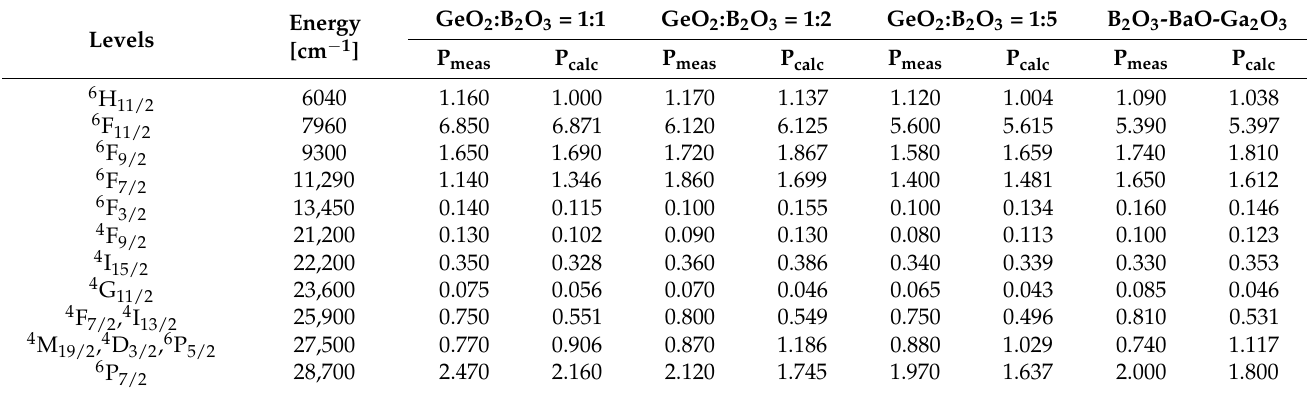
Table 4. Measured and calculated oscillator strengths (P × 10 − 6 ) for Dy 3+ ions in B 2 O 3 -BaO-Ga 2 O 3